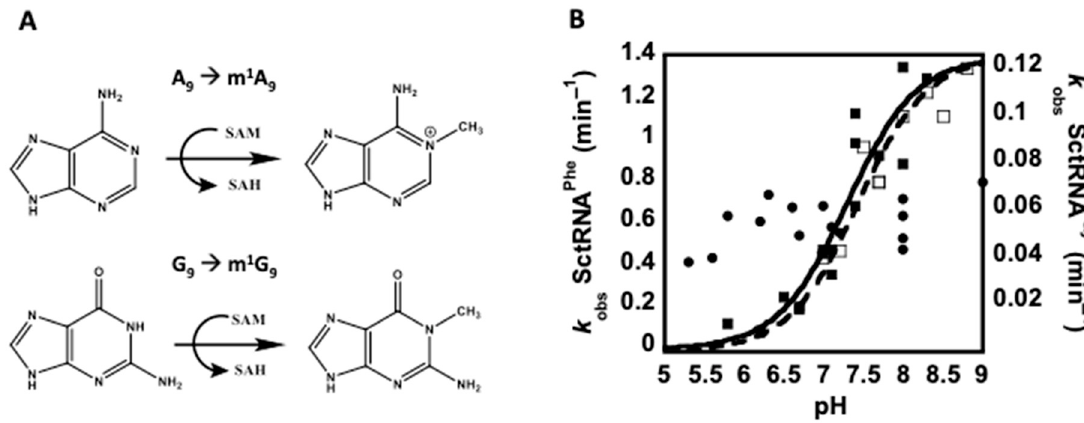
Figure 1. m 1 A 9 and m 1 G 9 catalysis by TkTrm10. ( A ) TkTrm10 uses S -adenosyl methionine (SAM) as the methyl-group donor for m 1 A 9 and m 1 G 9 formation. ( B ) pH-rate profiles for m 1 G 9 vs m 1 A 9 formation catalyzed by TkTrm10. Single turnover k obs (min − 1 ) rates at saturating enzyme concentration were measured as a function of pH for SctRNA Phe (m 1 A 9 , filled circles), SctRNA Phe -G9 (m 1 G 9 , filled squares), and SctRNA Gly (m 1 G 9 , open squares). Data from at least three independent experiments were fit to Equation (2) to obtain the reaction pKa values for SctRNA Phe -G9 (7.3 ± 0.1) and SctRNA Gly (7.4 ± 0.1), with errors representing the error associated with the curve fit. Note the difference in the Y -axis scale for comparison of SctRNA Phe (filled symbols) and SctRNA Gly (open symbols) rates.